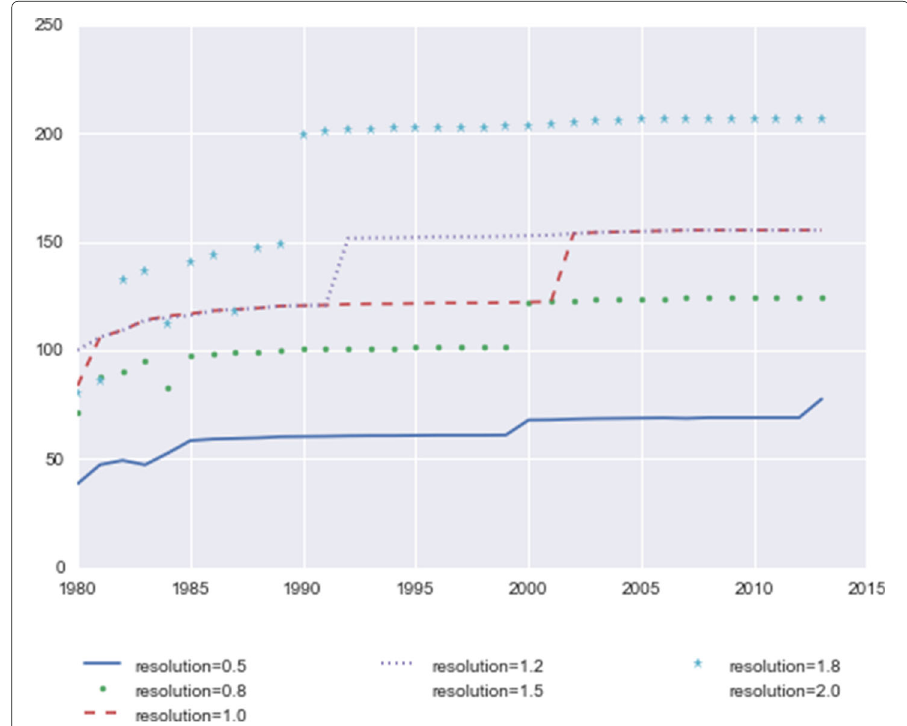
Fig. 2 Average community size at different resolutions. The x-axis indicates years from 1980 to 2013, and the y-axis indicates number of nodes in the